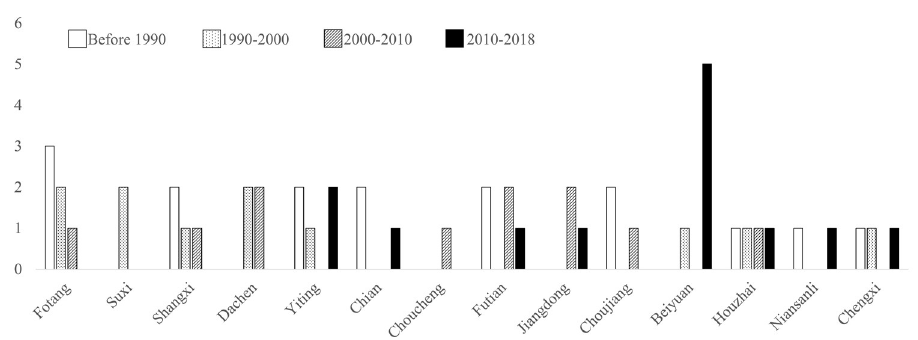
Fig 2. The increased number of Christian places in each subdistrict (town) of Yiwu over time. Here, we show the growth of Christian places in Yiwu city in four time periods from 1990 to 2018.